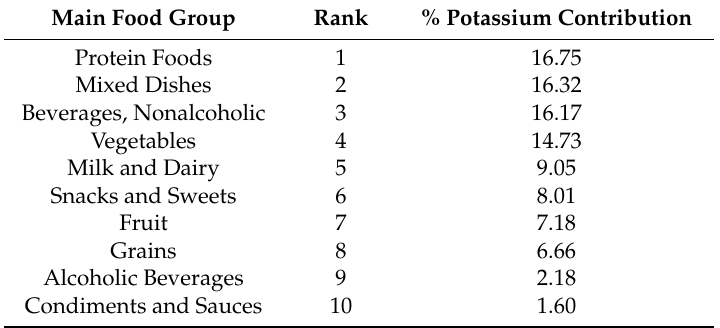
Table 6. Food sources of potassium contribution in the total U.S. diet, adults ≥ 51 years old ( n = 4522; gender combined; daily intake data; NHANES 2011–2014; main food groups contributing <1.0% not reported; data are Day 1 intakes).